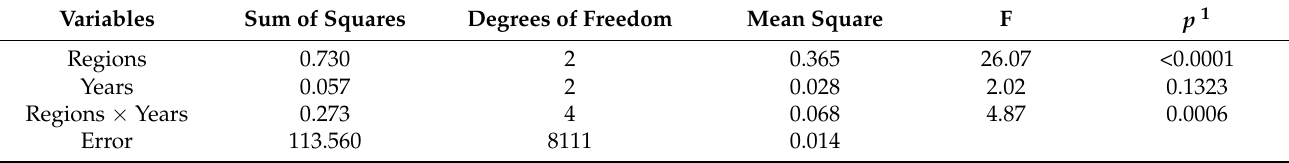
Table 5. The main effect and interaction by regions and years of HRQoL ( N = 8102).